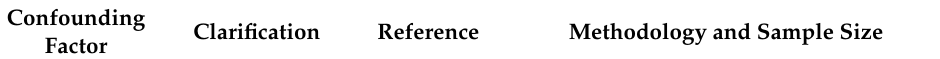
Table 1. Potential confounding factors that may impact risk estimation of endometriosis-associated ovarian